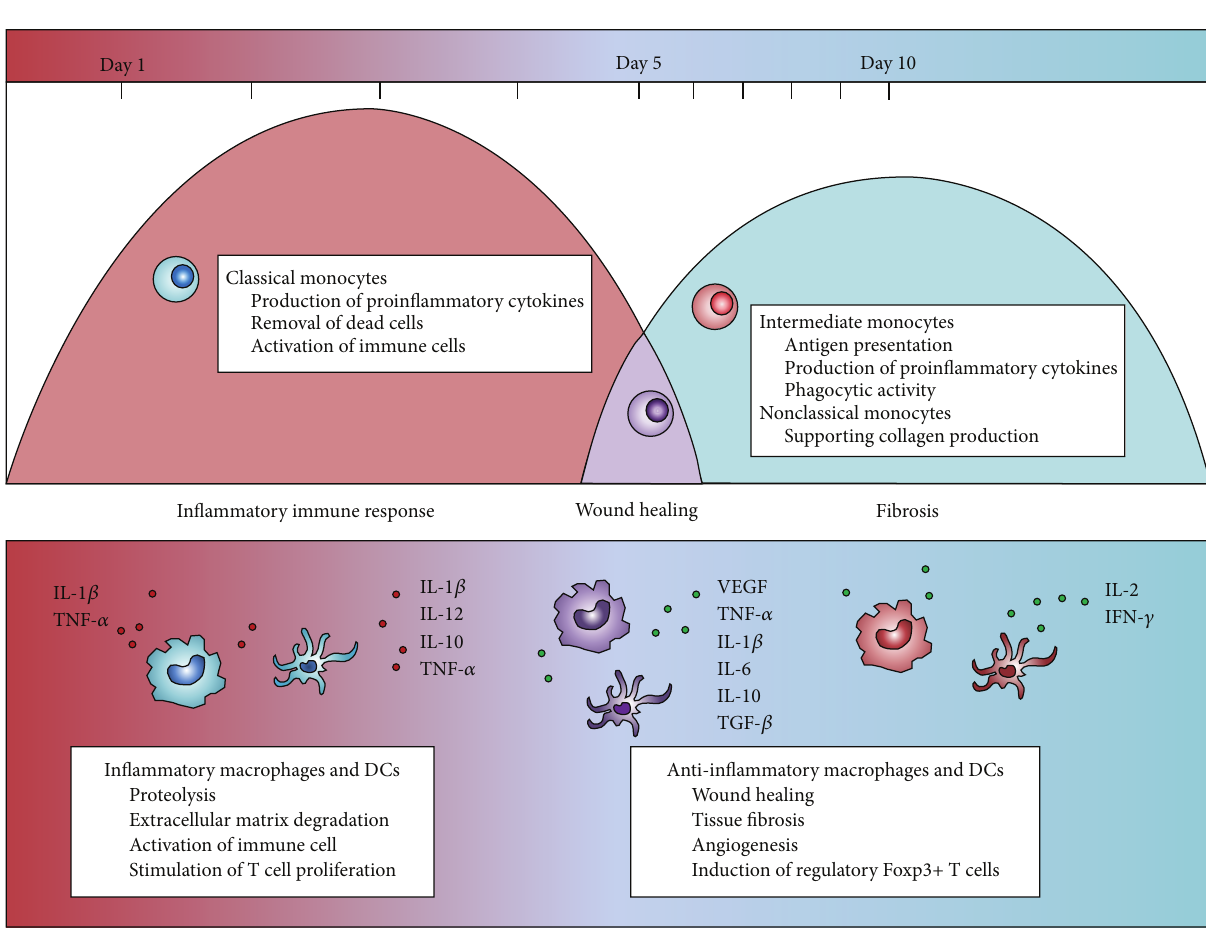
Figure3:TimecourseofhumanmonocytesubsetsrecruitmentandtheirdifferentiationintomacrophagesandDCsduringinflammation.The monocyte subsets are sequentially recruited to a site of inflammation. Their subsequent differentiation into distinct different macrophages and